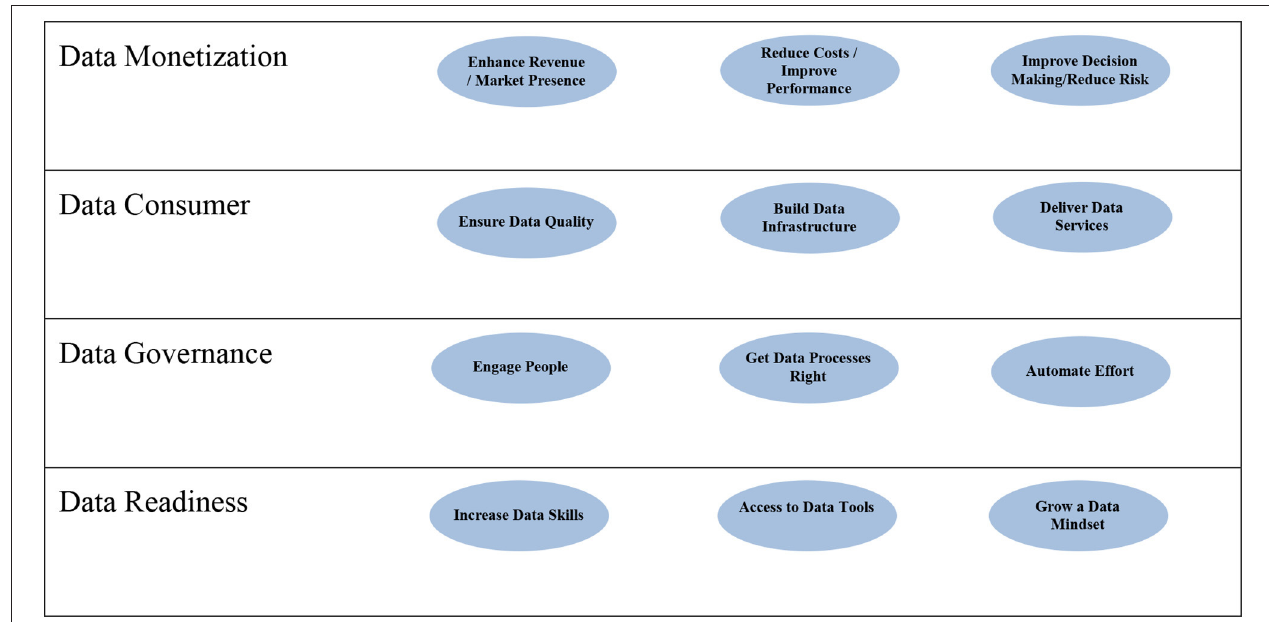
FIGURE 2 | Key perspective and goals for the balanced data